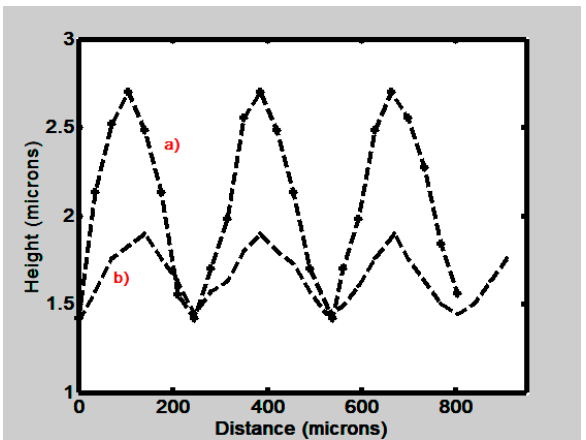
Figure 15. Profile height (µm) of a gelatin grating as a function of distance (µm). a) shows the profile after the gelatin thin film has absorbed water molecules. b) profile of a dry film.